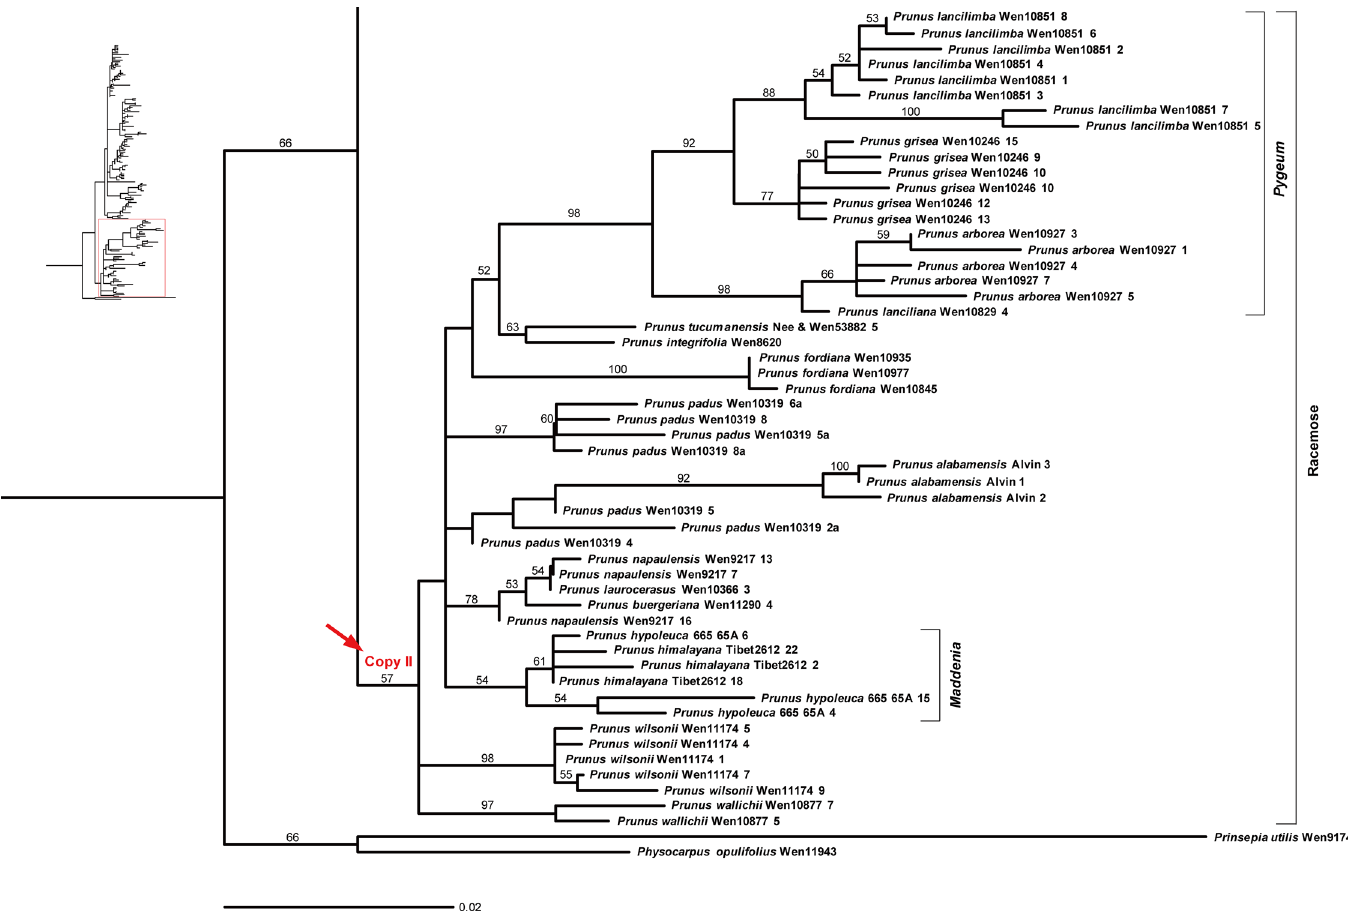
Fig 4. Maximum likelihood (ML) tree inferred from the At103 DNA sequences of Prunus . The results of ML bootstrap analysis are shown above the branches. Bootstrap values > 50% are shown.